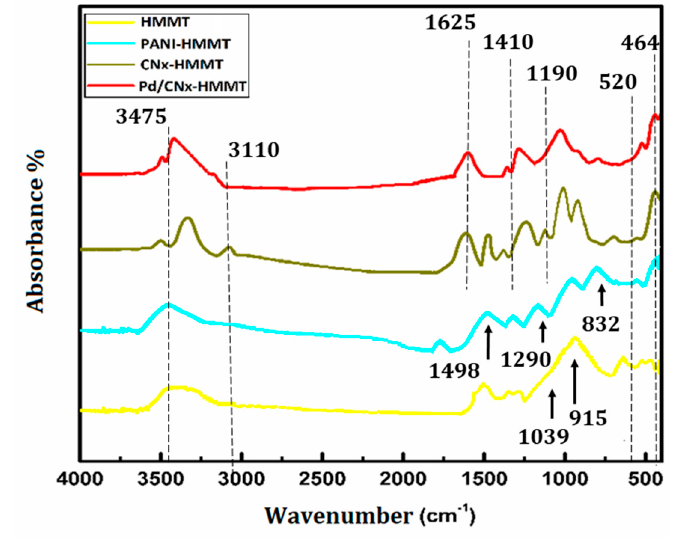
Figure 2. FTIR spectra of HMMT, PANI–HMMT, CNx-HMMT, and Pd/CNx-HMMT.